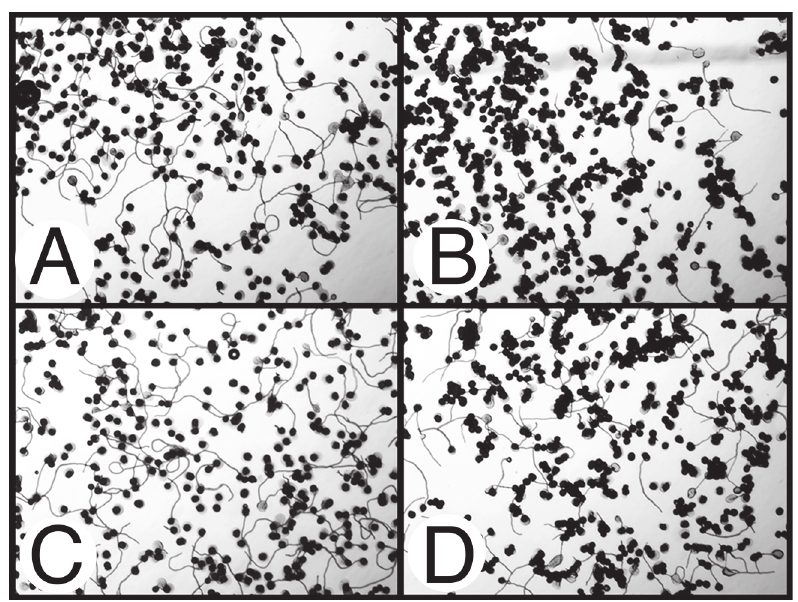
Fig 9. Photomicrographs of cotton pollen following a high temperature challenge. (A) pollen from plant 39 (AtHSP101 minus) germination at 28°C after treating flowers for five hours at 23°C, (B) pollen from plant 39 (AtHSP101 minus) germination at 28°C after treating flowers for five hours at 37°C, (C) pollen from plant 40 (AtHSP101 plus) germination at 28°C after treating flowers for five hours at 23°C, and (D) pollen from plant 40 (AtHSP101 plus) germination at 28°C after treating flowers for five hours at 37°C.